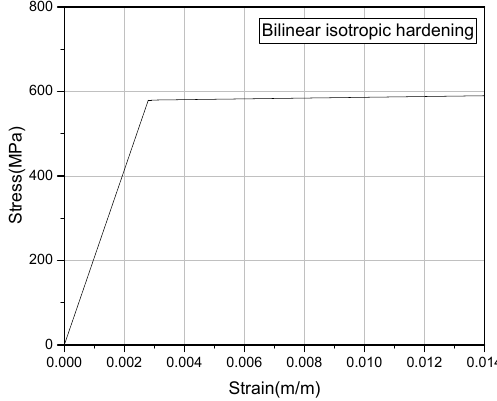
Figure 6. Stress–strain curve (580 MPa).